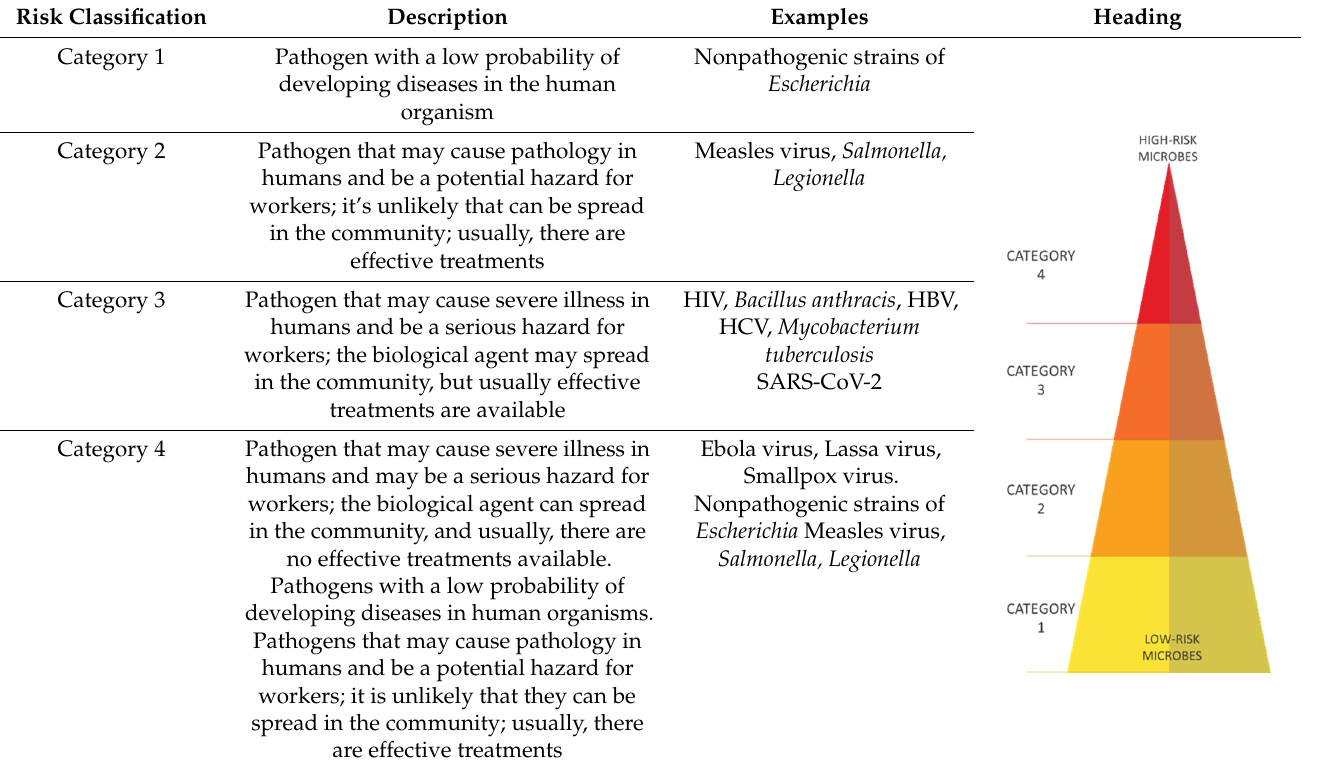
Table 2. Classification of biological agents.